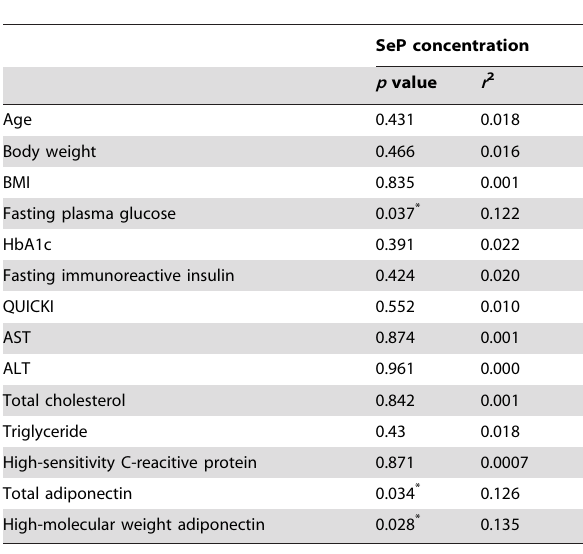
Table 2. Linear regression analysis of selenoprotein P concentrations with clinical parameters.